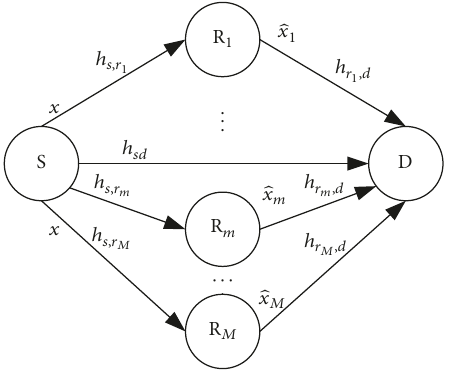
Figure 1: A multibranch cooperative system